Question: Summarize what this figure shows in one sentence.
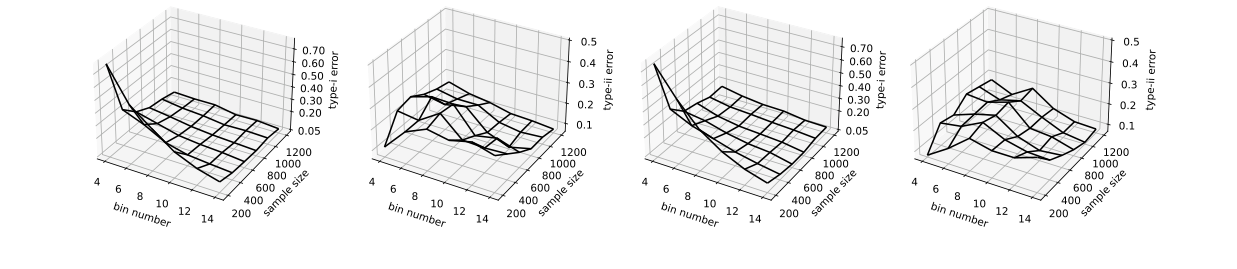
Answer: Type I and type II error rates with respect to the bin number and sample size. We consider two settings for data generating, with setting I (left) using the confounding graph in Fig. 1 (a), and setting II (right) using the mediation graph in Fig. 1 (b).